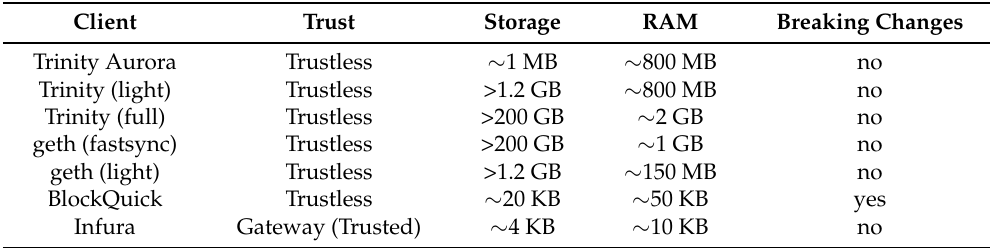
Table 4. Approx. specifications for various Ethereum clients compared to the Trinity Aurora